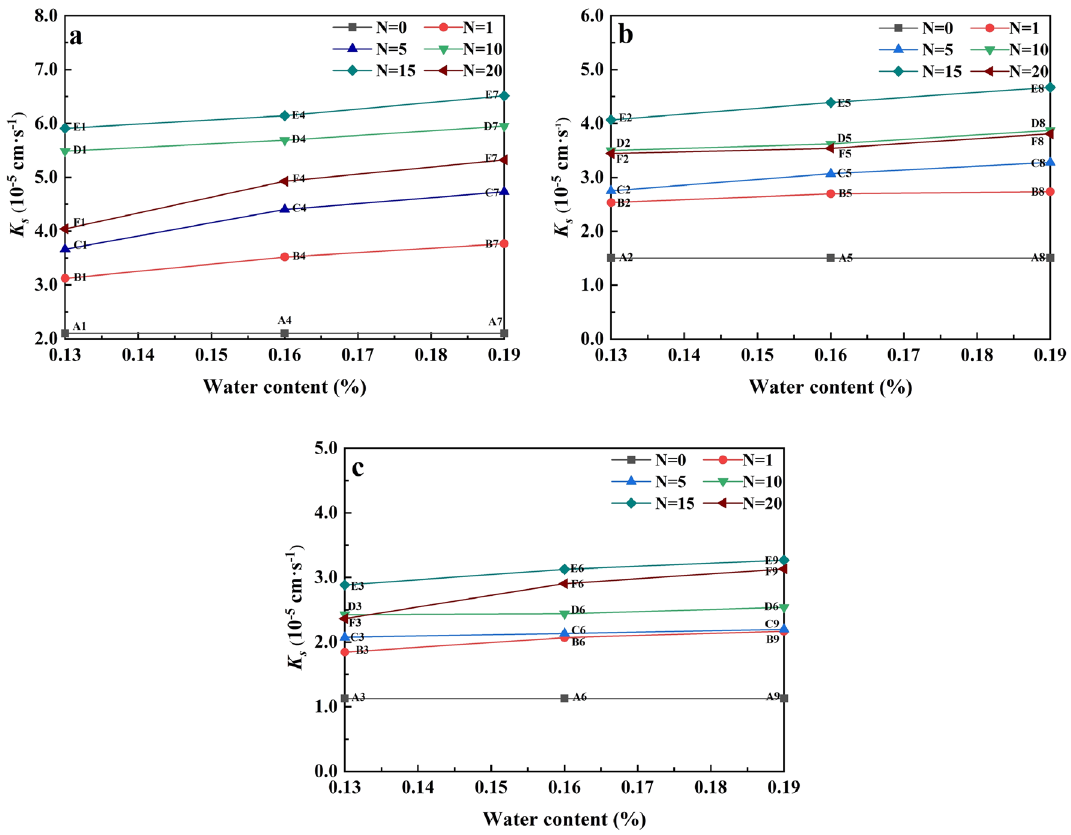
Figure 8. The changes of K s with water content of water-remolded soils at the study site in the floodplain of southwestern Shandong Province: ( a ) ρ d = 1.48 g cm −3 , ( b ) ρ d = 1.53 g cm −3 and ( c ) ρ d = 1.58 g cm −3